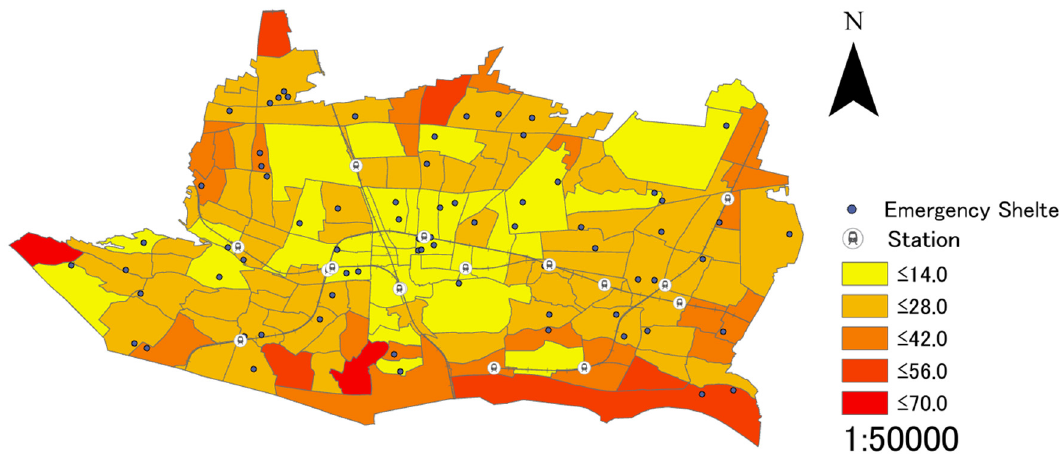
Geosciences 2019 , 9 , x FOR PEER REVIEW Figure 7. Result for Fuchu City with the specialization coefficient of elderly population as a weighted coefficient.